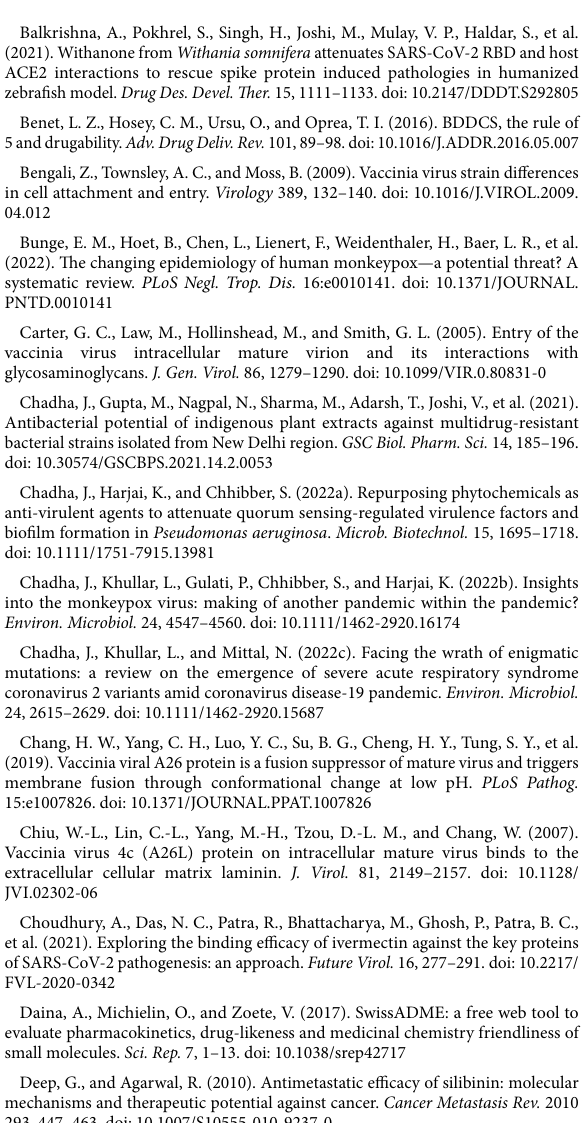
SUPPLEMENTARY FIGURE S9 Molecular dynamics simulation analysis of silibinin, oleanolic acid, and ursolic acid docked against the H3 protein (PDB ID: 5EJ0). Left vertical panel shows the covariance matrix. Correlated region has been depicted in red, uncorrelated region in white, and anticorrelated region in blue. Right vertical panel shows elastic network of the docked complexes (dark gray regions indicates more stiffer